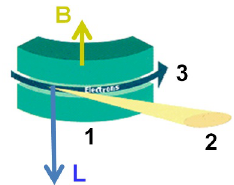
Figure 1. Radiative OAM polarization of twisted electrons: 1 – magnet, 2 – synchrotron light, 3 – twisted electron beam. The directions of the main magnetic field, B , and the final orbital polarization of electrons, L , are